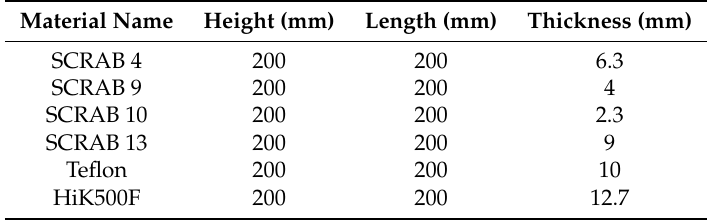
Figure 1. SCRAB-II materials under test. Table 1. Materials under test.